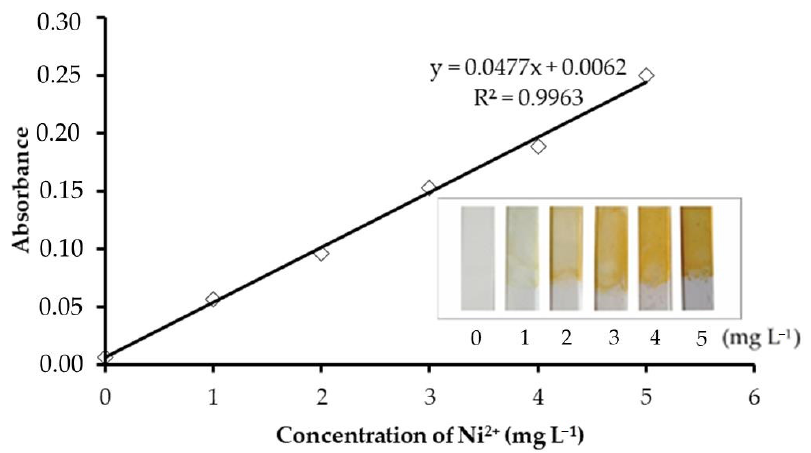
Figure 6. Calibration curve for nickel determination at pH 8.5.